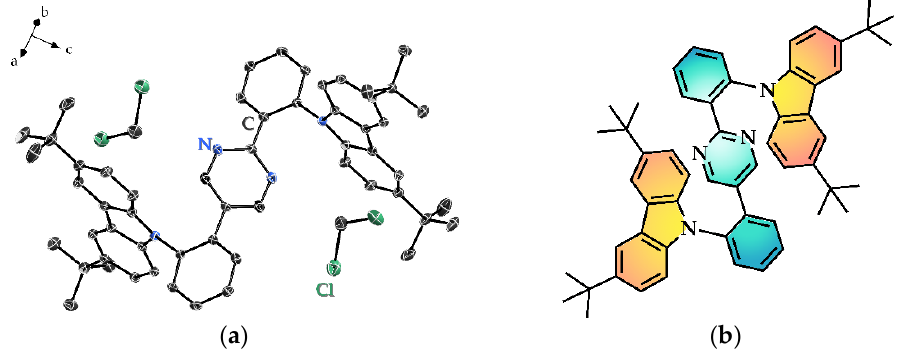
Figure 1. ( a ) The asymmetric unit of the crystalline structure of PDPC . Hydrogen atoms are omitted for clarity; ( b ) the chemical structure of PDPC , in which the acceptor part is tinted green, while the donor counterpart orange.